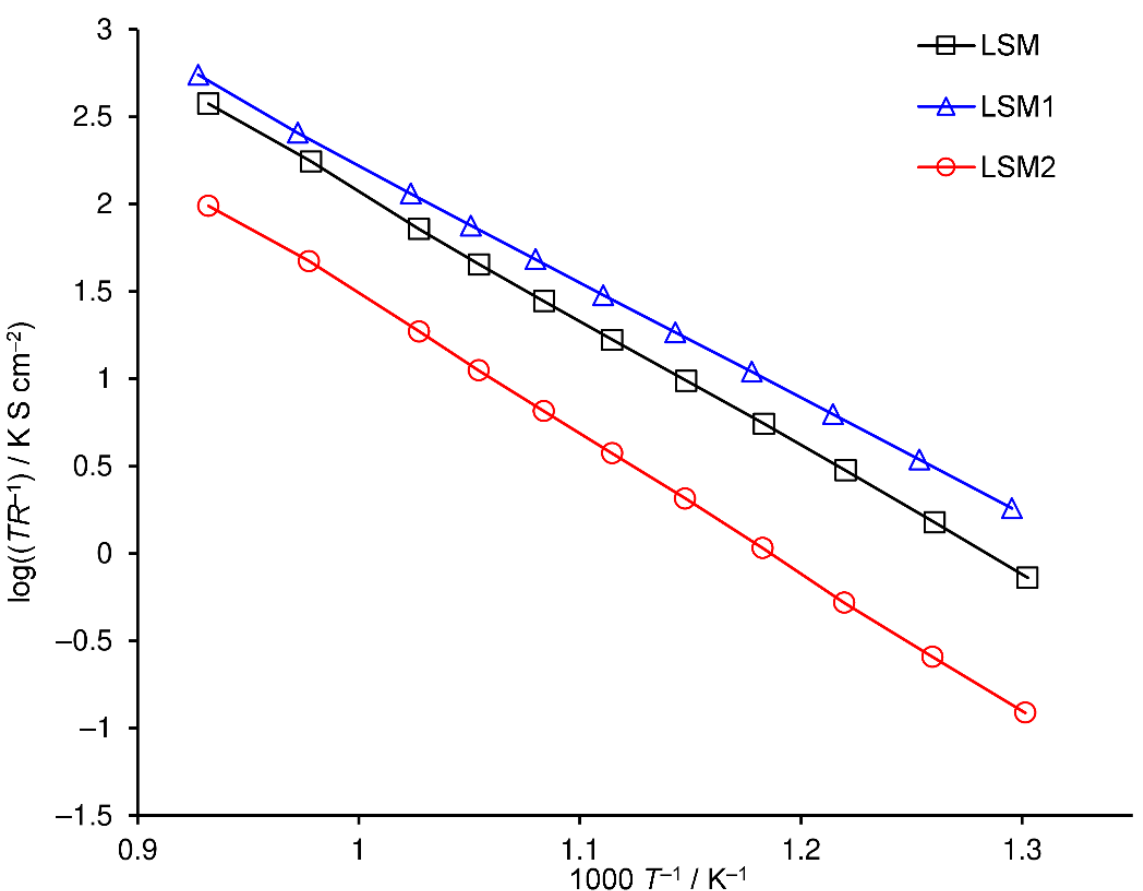
Figure 6. Arrhenius plot of reciprocal polarization resistance of cathodes sintered at 1100 °C, LSM (black squares), LSM1 (blue triangles), and LSM2 (red circles).